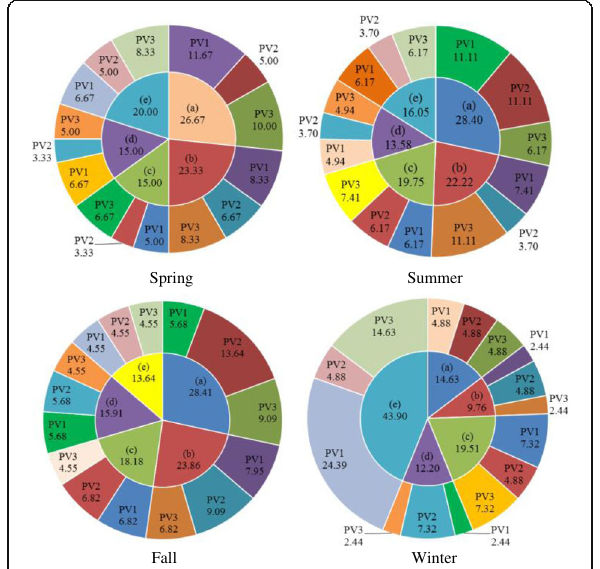
Fig. 8 The distribution probability of typical scenarios in the four seasons of the year (%)